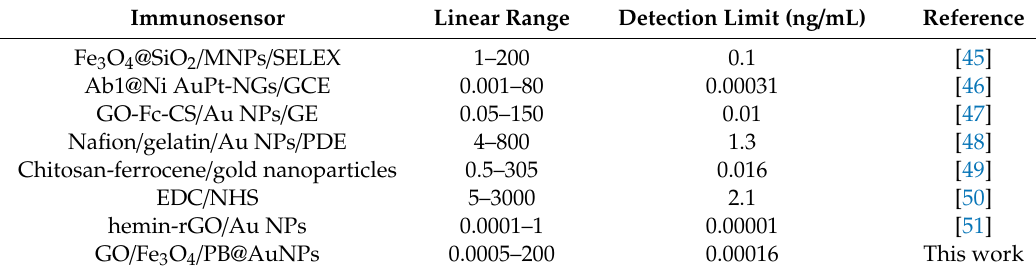
Figure 8. ( A ) The differential pulse voltammetry (DPV) response of the immunosensor after incubation with different concentration of HBsAg, from a to k: 0, 0.5 × 10 − 3 , 1 × 10 − 3 , 1 × 10 − 2 , 5 × 10 − 2 , 1 × 10 − 1 , 5 × 10 − 1 , 1, 10, 100 and 200 ng/mL in pH 7.4 PBS; ( B ) linear relationship between the current response and different concentration of HBsAg. Table 1. Comparison with other reported methods for the determination of